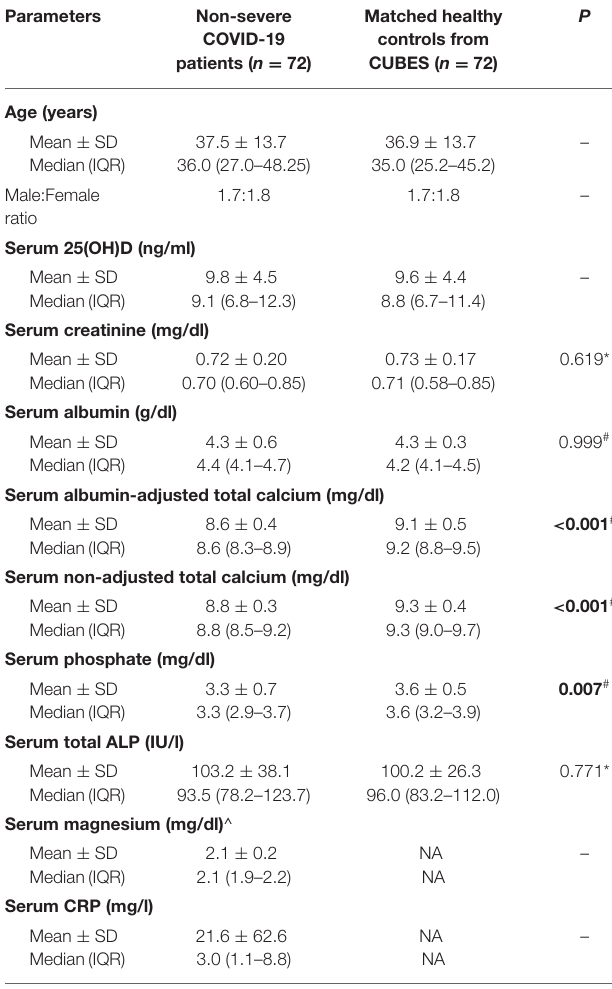
TABLE 2 | Showing comparison of demographic and baseline biochemical parameters between non-severe COVID-19 patients (cases) and healthy controls.